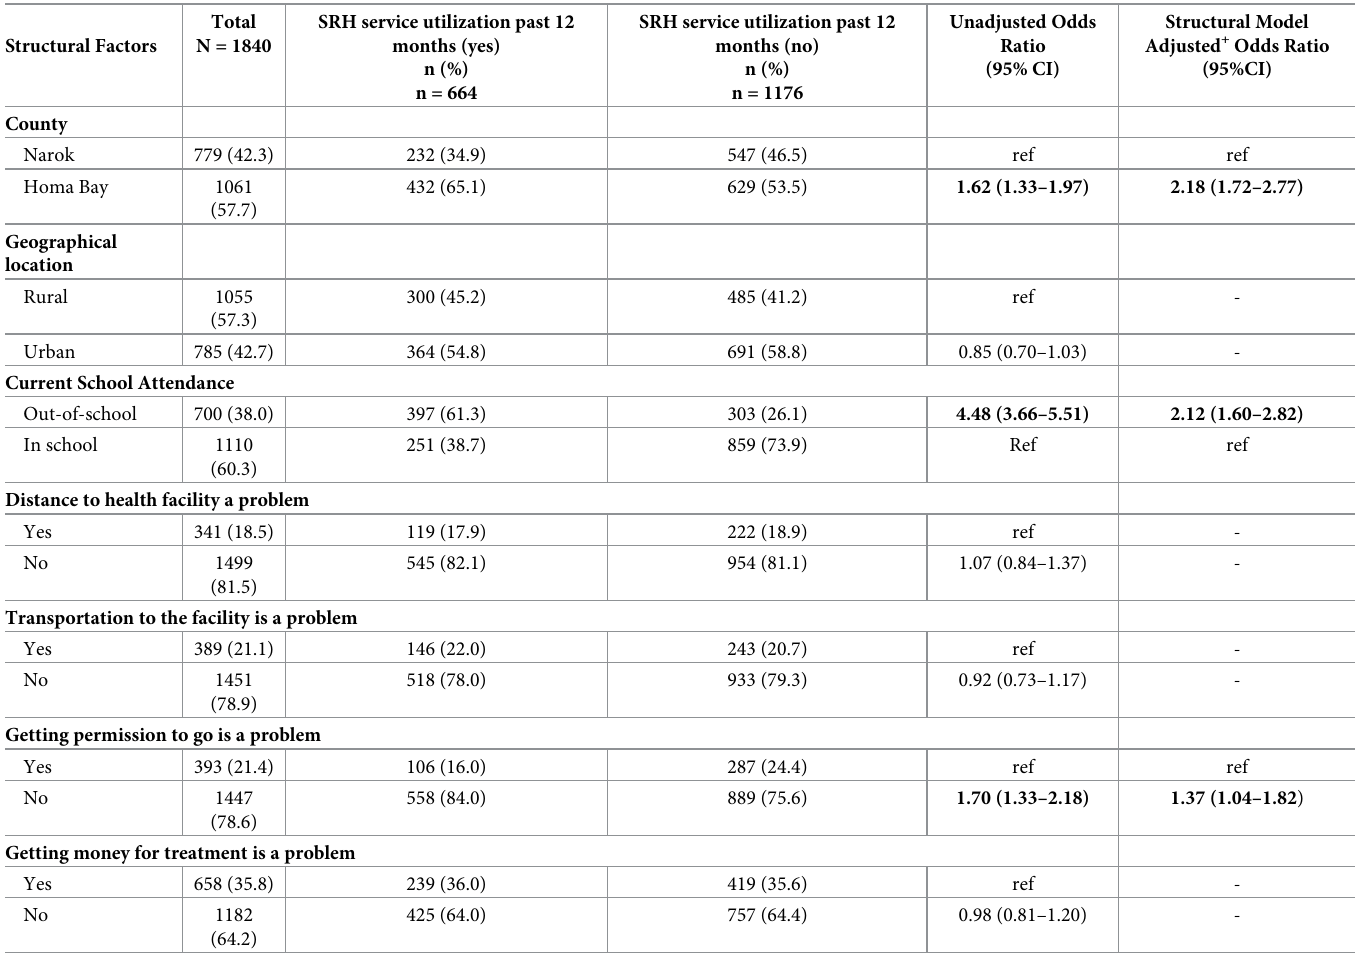
Table 2. Structural factors associated with SRH utilization among adolescents aged 15–19 in Kenya. Structural